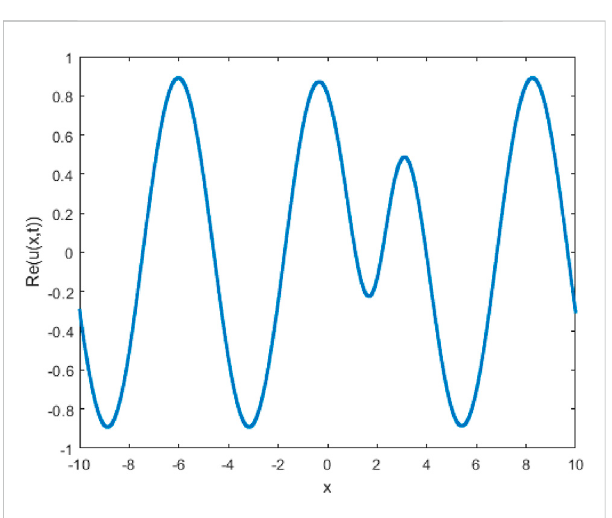
FIGURE 7 2D plot for solution (3.16) with k = 1.1, c = − 2.8, and γ = 1.